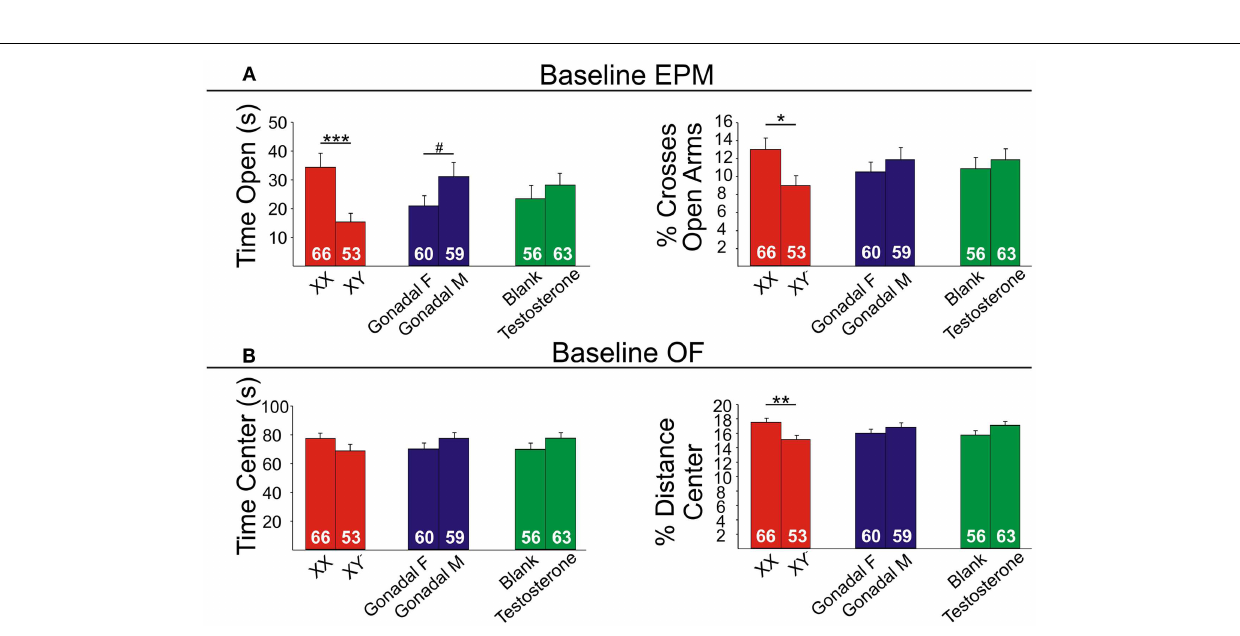
FIGURE 6 | Baseline emotionality measures in FCG mice. (A) Baseline elevated plus maze (EPM) results for time (left) and percent crosses (right) into open arms. (B) Baseline open Field (OF) results for time (left) and percent